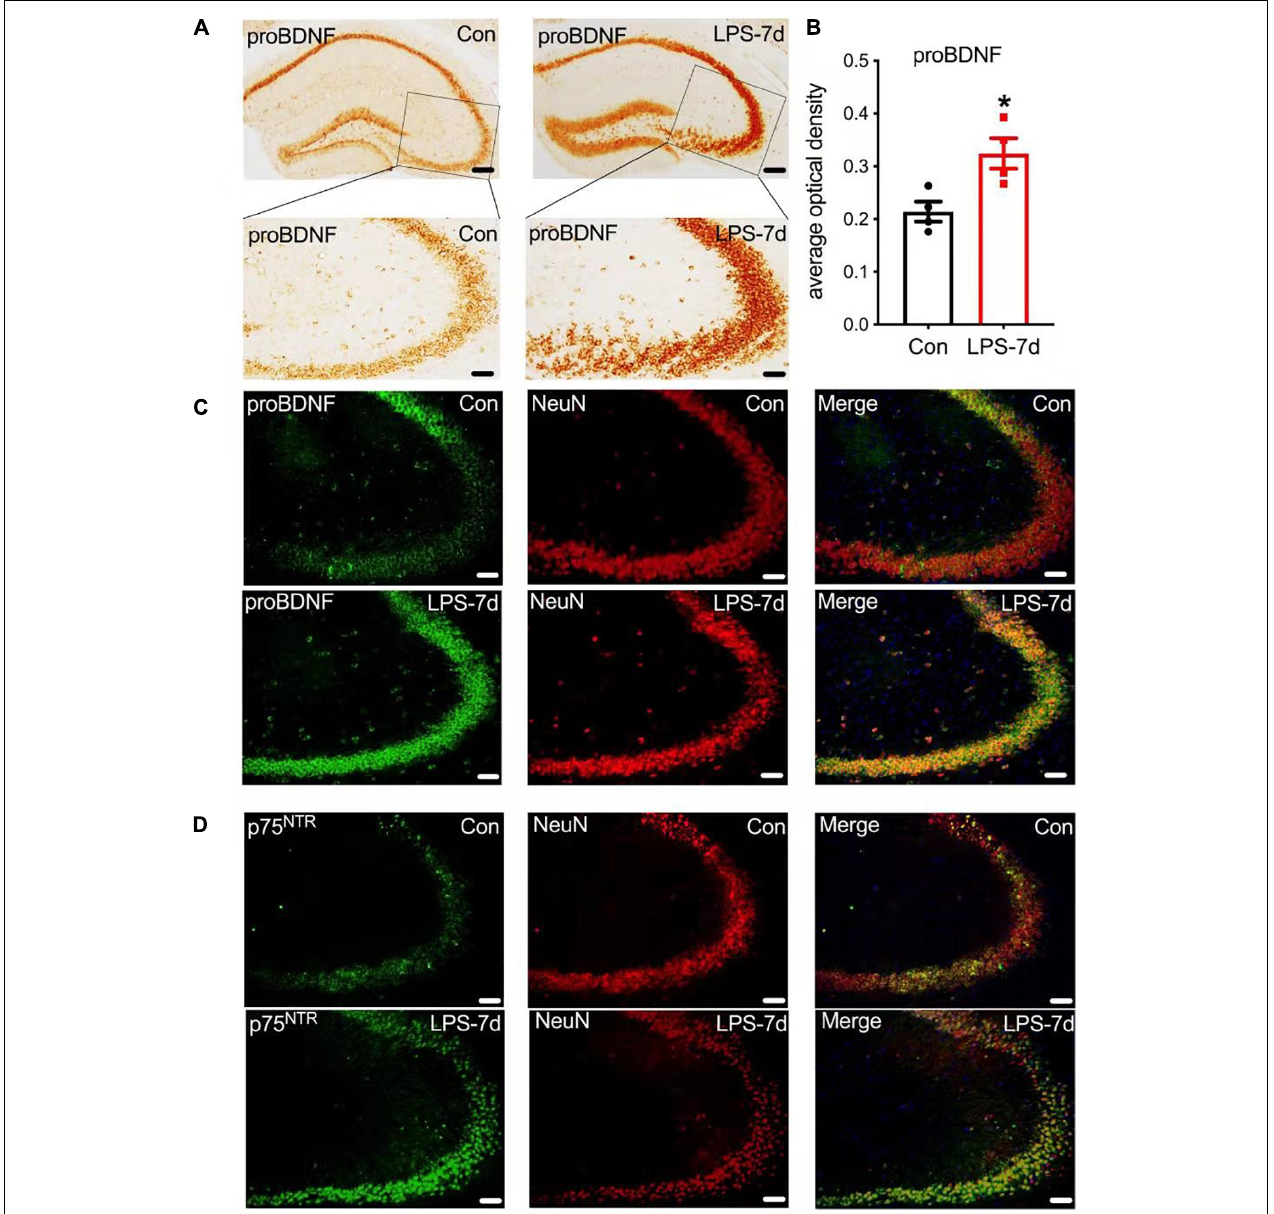
FIGURE 3 | proBDNF and its receptor p75 NTR are mainly expressed in hippocampal neurons. (A,B) proBDNF accumulated in hippocampal neurons (upper scale bar = 100 µ m, lower scale bar = 50 µ m, n = 4/group). (C,D) proBDNF and its receptor p75 NTR mainly co-existed in the neuron (scale bar = 50 µ m, n = 4/group). Data are expressed as mean ± SEM. * p <